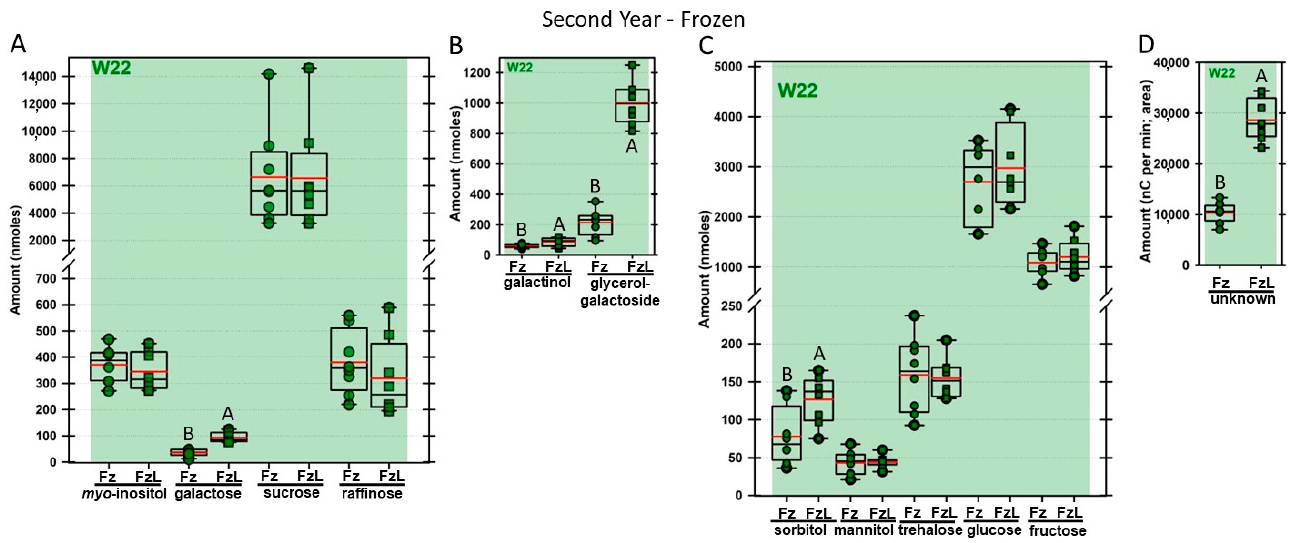
Figure 8. Carbohydrates were analyzed from W22 wild type (W22) maize leaves. The disks were frozen after harvest (Fz; dark green circles) or were frozen and then lyophilized to dryness (FzL = frozen lyophilized; dark green squares). The same carbohydrates are depicted, and statistically significant differences are determined in the same manner as in Figure 4.